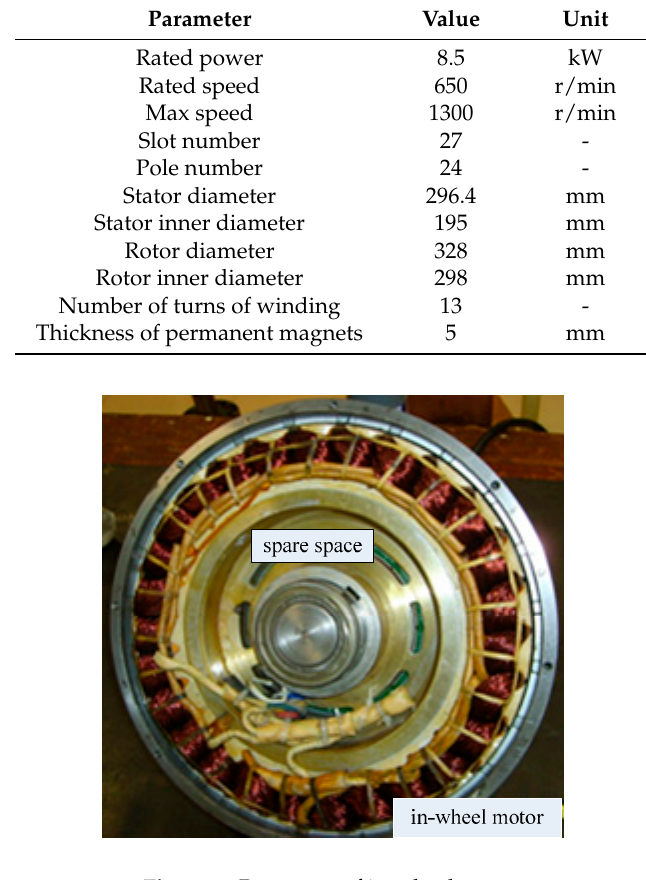
Figure 1. Prototype of in-wheel motor.